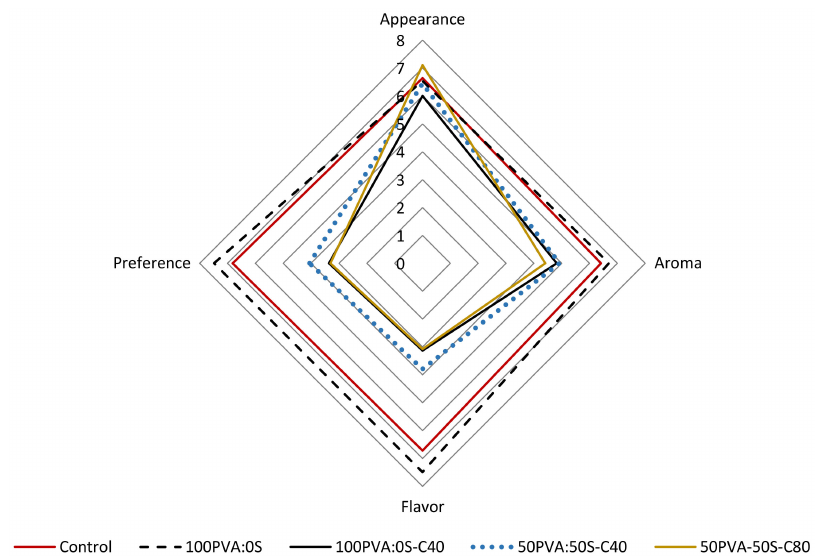
Figure 3. Sensory profile of the uncoated (control) and the di ff erent coating formulations applied onto whole fresh apples in terms of appearance, aroma, flavor, and